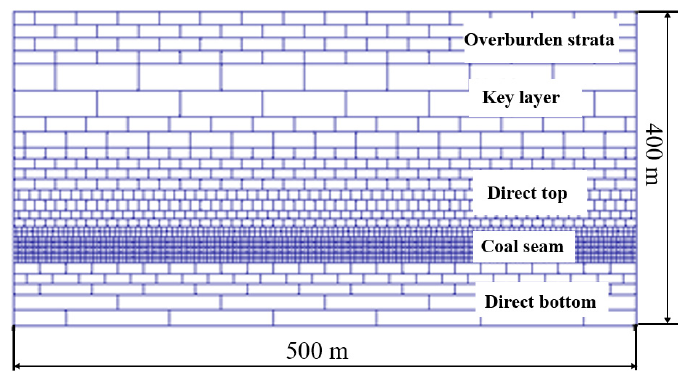
Figure 19. Block model of primitive surrounding rock structure.